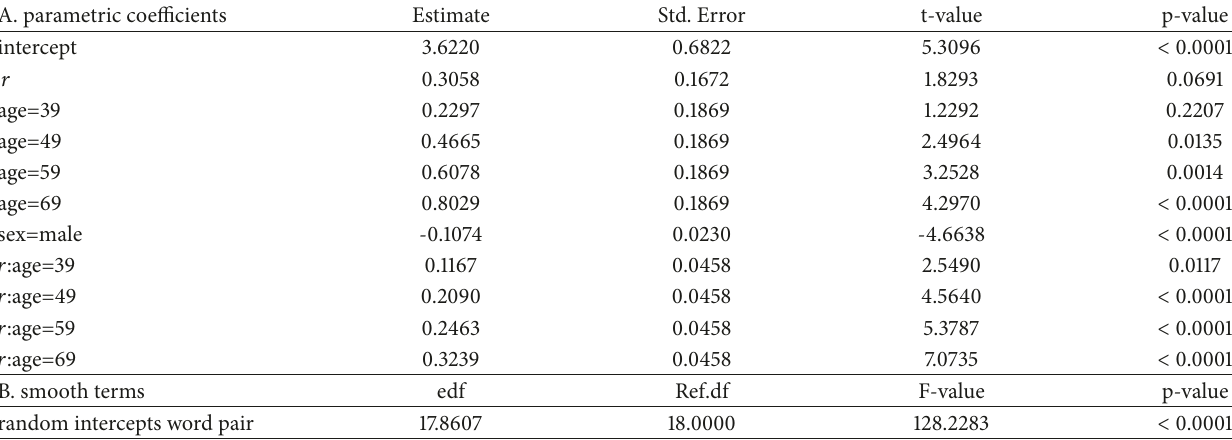
Table 1: Linear mixed model fit to paired associate learning scores with the correlation 𝑟 of the row vectors in S of the paired words as predictor. Treatment coding was used for factors. For the youngest age group, 𝑟 is not predictive, but all other age groups show increasingly large slopes compared to the slope of the youngest age group. The range of 𝑟 is [−4.88, −2.53] ; hence larger values for the coefficients of 𝑟 and its interactions imply worse performance on the PAL task.